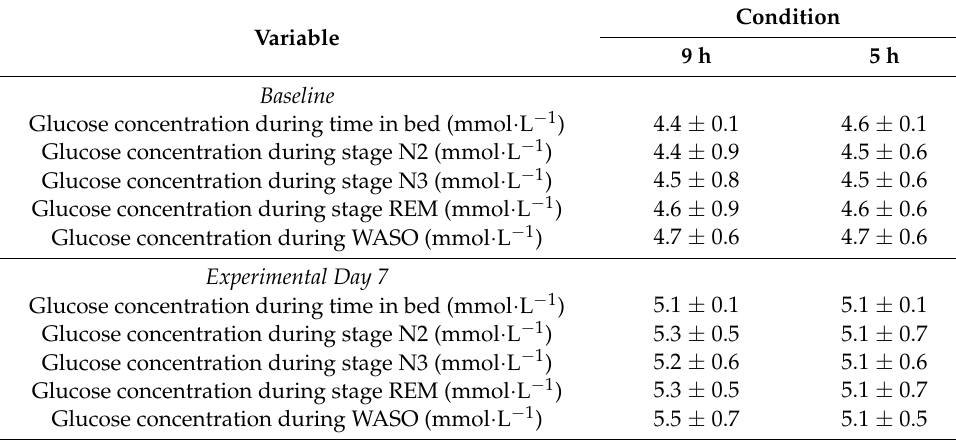
Table 3. Average glucose concentrations during baseline night and experimental night E7 in the 9 h and 5 h